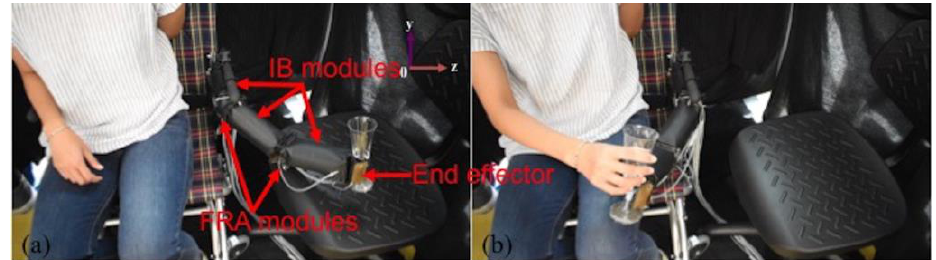
Figure 14. ( a,b ) Photo of TERA on a wheelchair for the disabled. Grasping and moving of a glass. The pneumatic pressure for IB modules is 20 kPa and the actuating FRA module of the respective joint is 50 kPa.